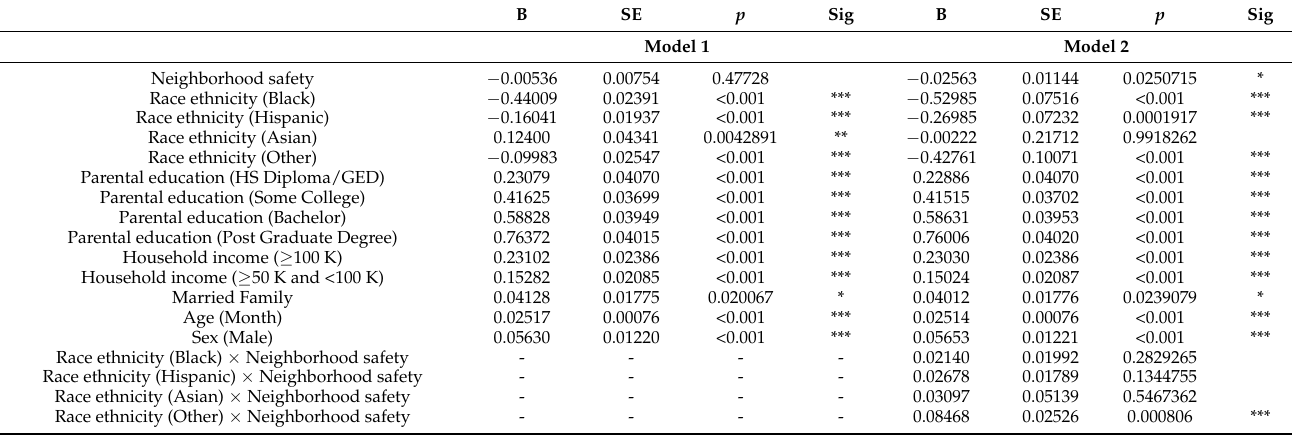
Table 3. Summary of mixed-effects regressions on the association between parent’s neighborhood safety and children’s cognitive performance (general cognition) overall and by